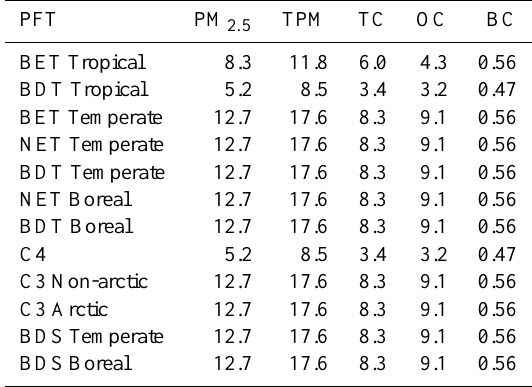
Table 4. PFT-specific emission factors (gspecie(kgdm) − 1 )